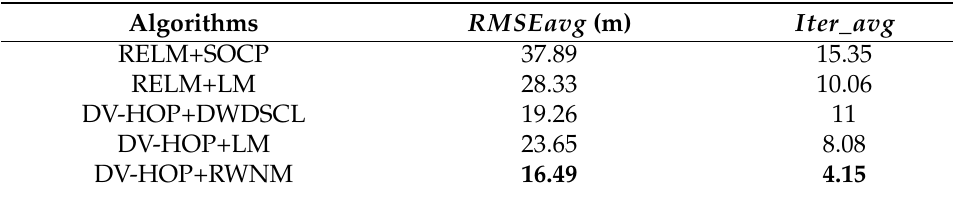
Table 6. RMSEavg and Iter _ avg at different levels of outliers Θ from 0% to 50%, R = 35 m and nfe = 0.1 under anisotropic networks, the best performances in RMSE average and iteration average are denoted in bold face.